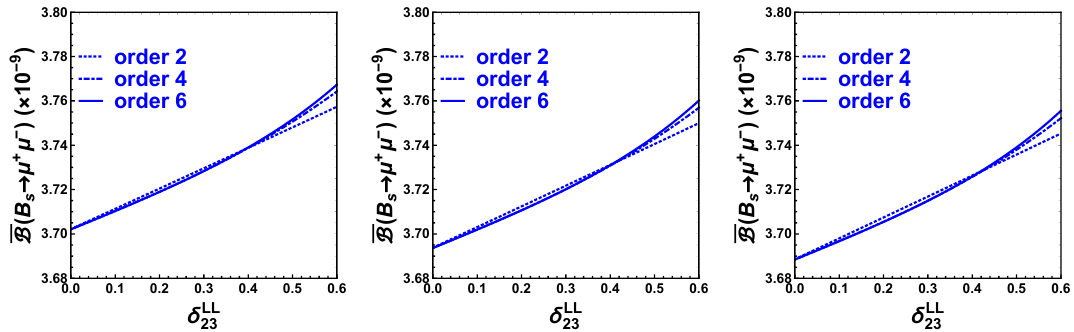
Figure 4 . Variation of B ( B s ! (cid:22) + (cid:22) (cid:0) ) with respect to (cid:14) LL p M S is (cid:12)xed at 1100 (left), 1300 (middle), and 1500 GeV (right), respectively. The dotted, dot- 2 dashed, and solid blue curves represent the results with squark cutting-o(cid:11) MI order of 2, 4, and 6,